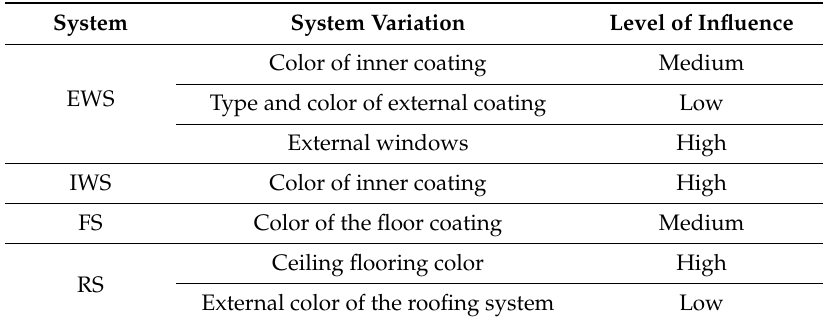
Table 24. Influence level of the variations adopted in the luminous performance in relation to the reference